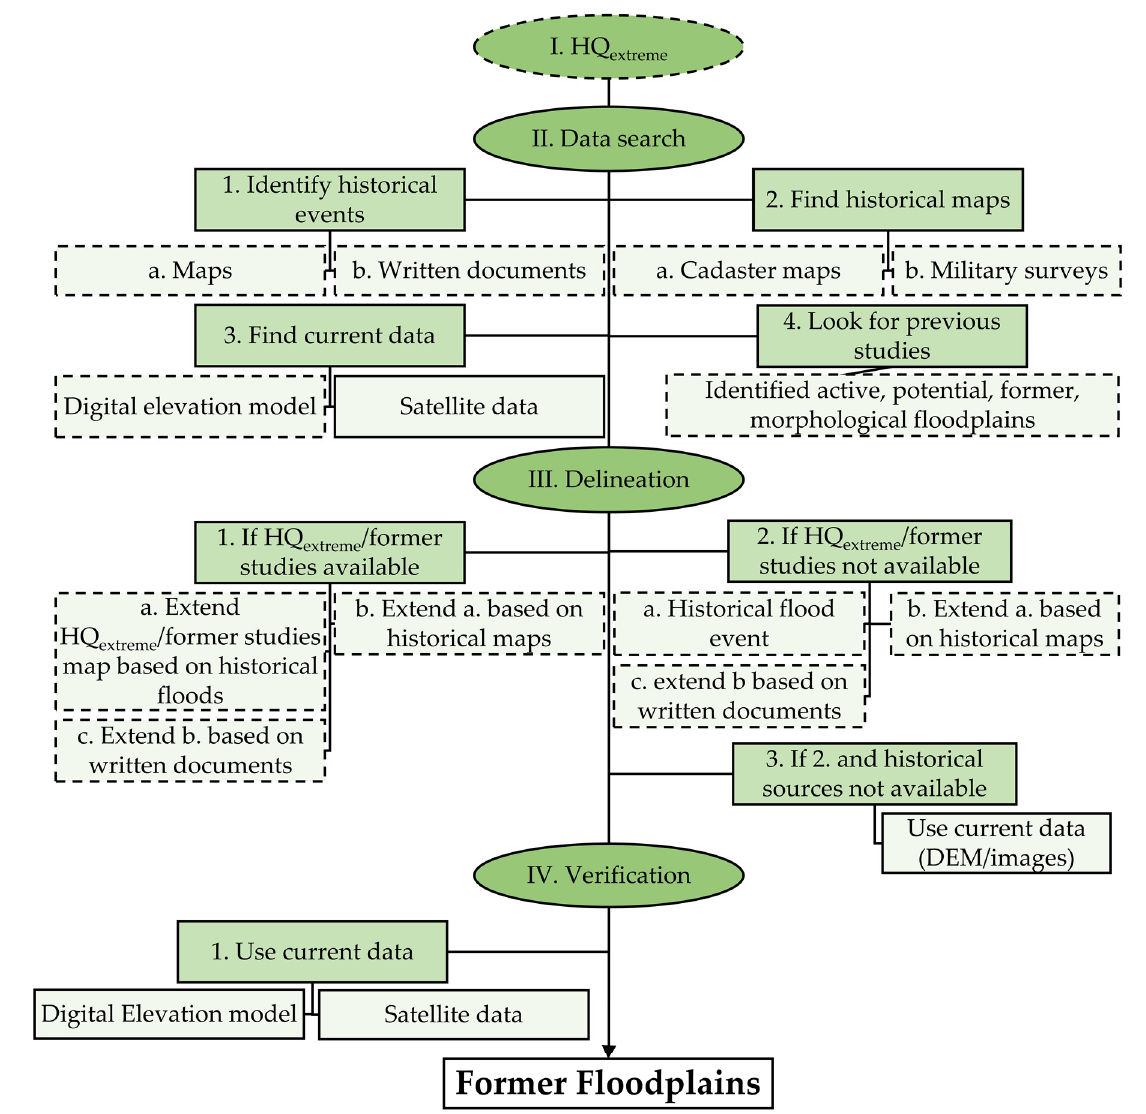
Figure 2. Schematic approach for the identification of former